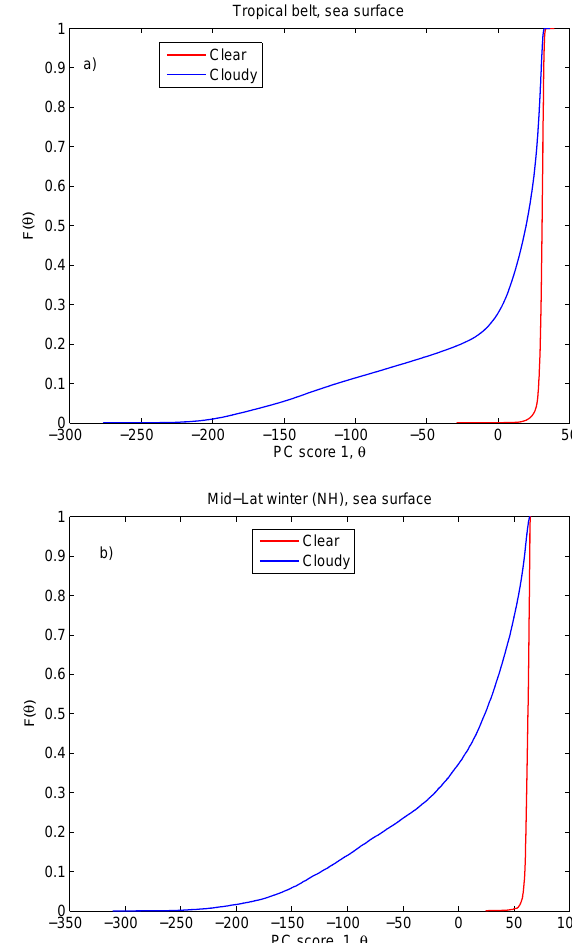
Figure 4. Example of covariance matrix of the vector x for the case Fig. 4. Example of covariance matrix of the vector x for the case of Fig. 4. Example of covariance matrix of the vector x for the case of of the tropical climate zone and sea surface; top panel, covariance the tropical climate zone and sea surface; top panel, covariance ma- matrix (numbering of rows and columns is consistent with the statis- the tropical climate zone and sea surface; top panel, covariance ma- tic numbering shown in Table 3); bottom panel, eigenvalues. trix (numbering of rows and columns is consistent with the statistic trix (numbering of rows and columns is consistent with the statistic numbering shown in Table 3); bottom panel, eigenvalues. numbering shown in Table 3); bottom panel, eigenvalues.